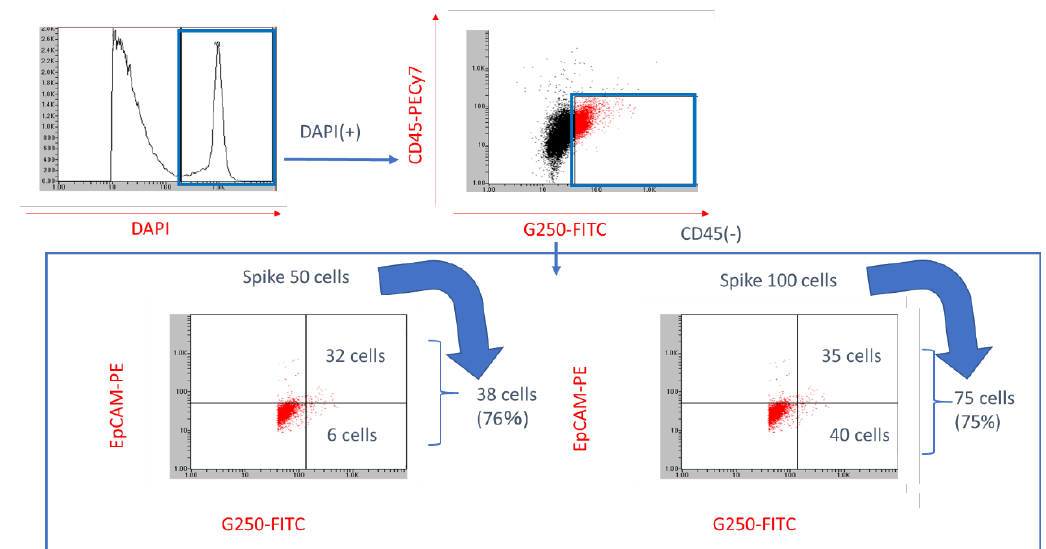
Figure 3. Identification rate of RCC CTC using On-chip Sort ® with G250 antibody. Flow cytometric analysis of mixture of PBMCs and VMRC-RCW cells. The cluster of RCC cells is readily identified based on its G250 expression and CD45 negativity. Epithelial cellular adhesion molecule (EpCAM) staining was performed simultaneously as a comparison of G250 staining.